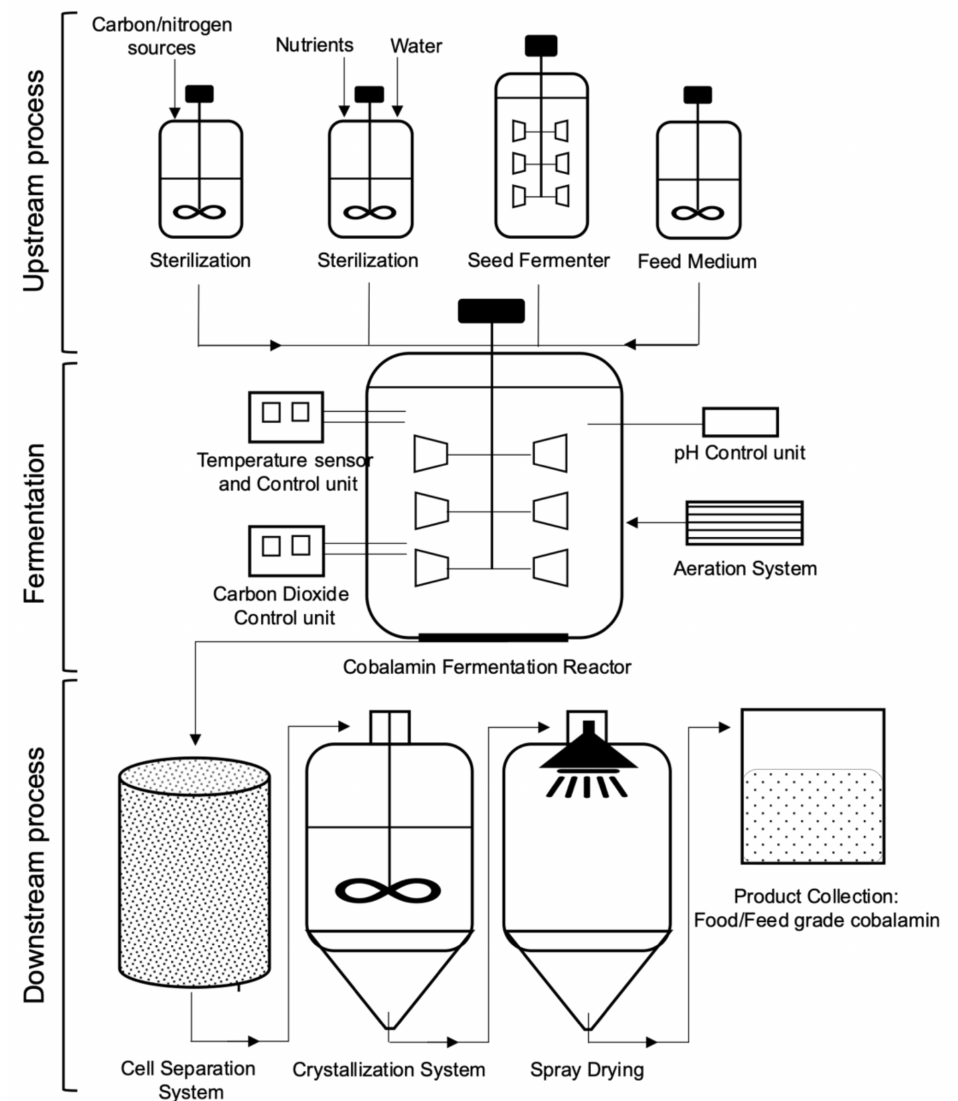
Figure 5. General flowsheet of the cobalamin industrial production applicable for aerobic process in P. denitrificans